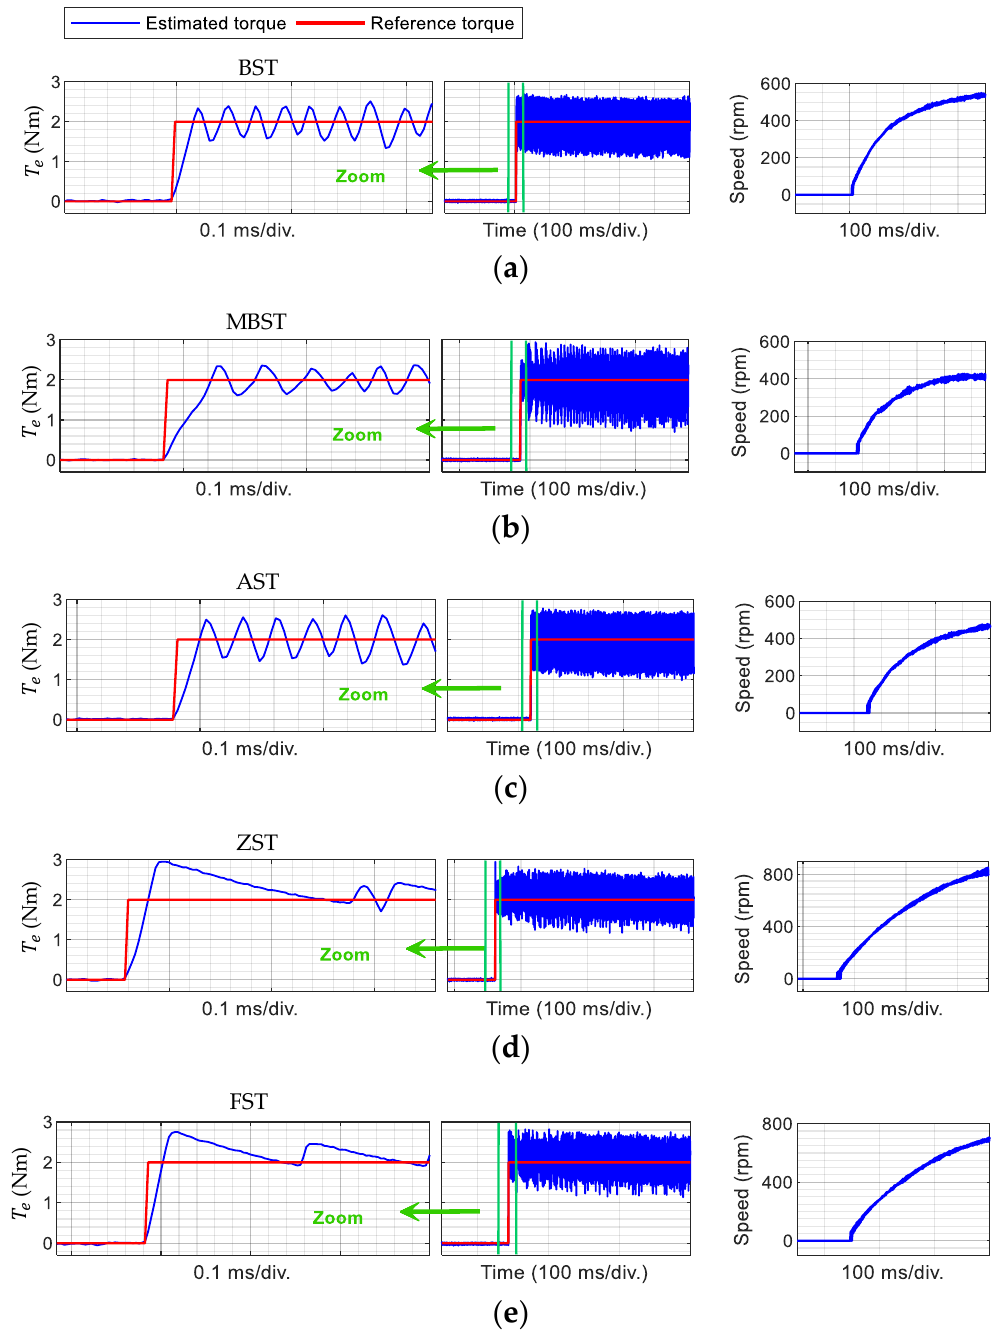
Figure 8. The torque dynamic response and the corresponding speed response for step change in the reference torque from 0 to 2 Nm for the different STs: ( a ) BST; ( b ) MBST; ( c ) AST; ( d ) ZST; and ( e ) FST.